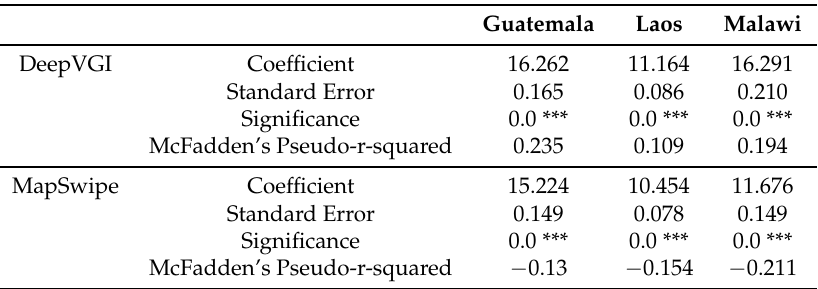
Table 3. Logistic Regression